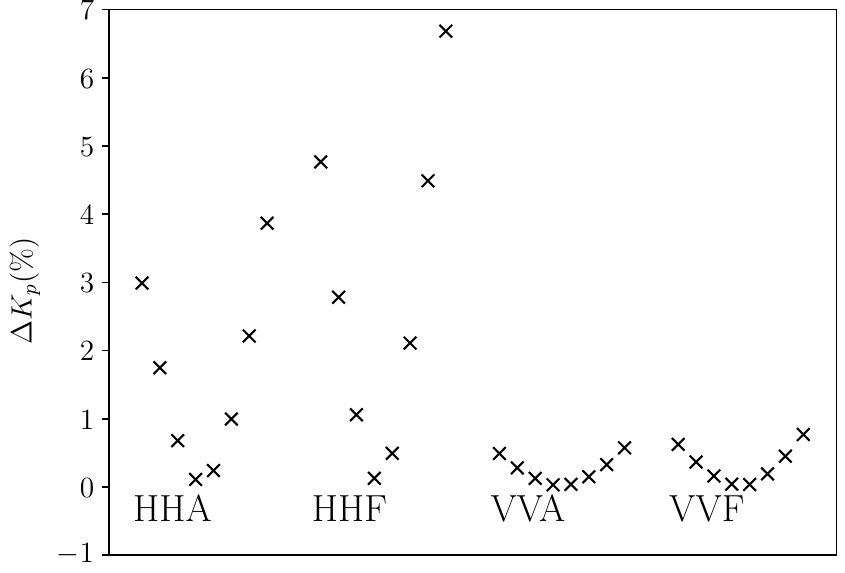
Figure 6. Impact of the intra-egg biases on K EMP p as a function of the slice index for each of the four pol-view flavors and for the σ 0 level corresponding approximately to 15 ms − 1 in the WCS. The estimates refer to the orbit with number 40,651. The 3-character strings in the panel represent the following: HH (VV) stands for HH-Pol (VV-Pol) and A (F) stands for aft (fore).